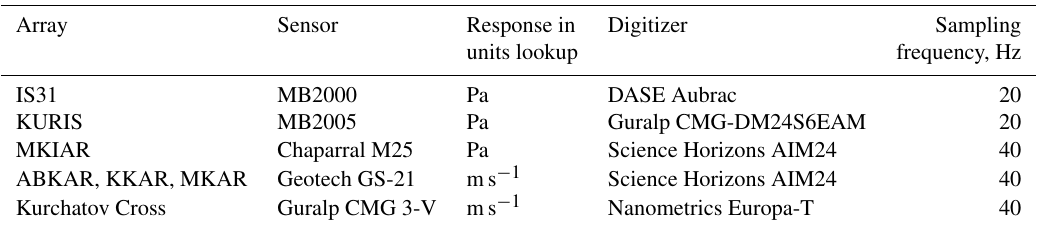
Table A1. Description of infrasound and seismic